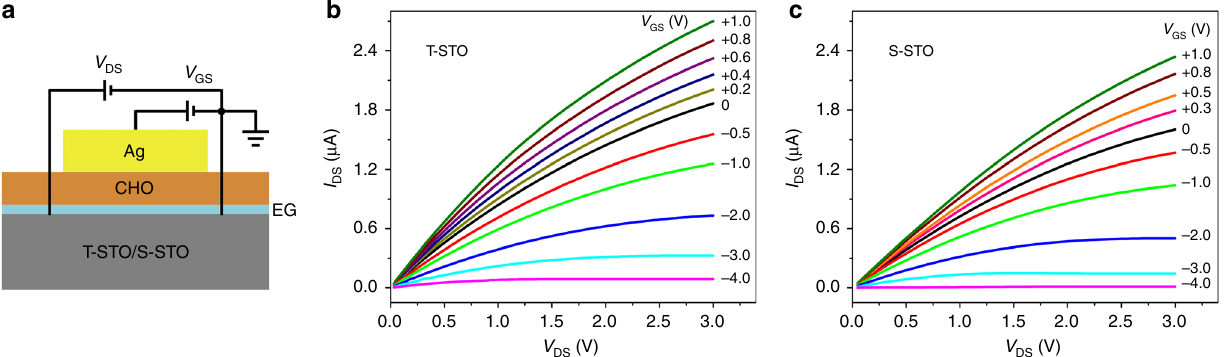
Fig. 3 Field-effect transistors with in situ annealed 8-uc CaHfO 3 /SrTiO 3 (CHO/STO) heterointerfaces. a Sketch of a device. The channel is 10 μ m in width and 100 μ m in length. The top gate electrode is a 100-nm-thick silver fi lm. Drain-source current ( I DS ) versus drain-source voltage ( V DS ) at different gate- source voltages ( V GS ) for b CHO grown on TiO 2 -terminated STO (T-STO) and c SrO-terminated STO (S-STO). All data were measured at